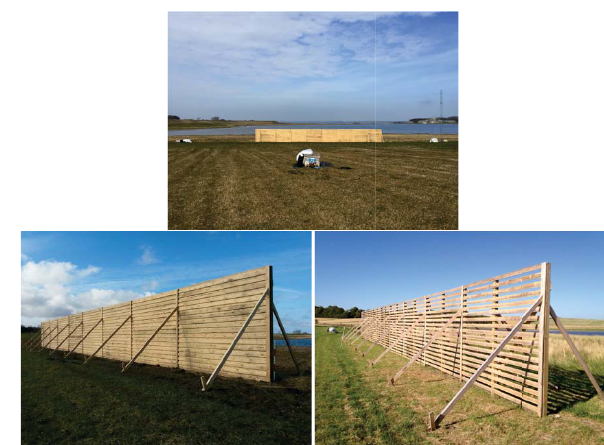
Figure3. Photographsofthefenceexperiment.(Top)overviewofthefenceandtheinstrumentationincludingthelidarsandthemast. Figure 3. Photographs of the fence experiment. Top panel: (Left)solidand(right)porousfencesetups overview of the fence and the instrumentation including the lidars and the mast. Left panel: solid and right panel: porous fence setups.